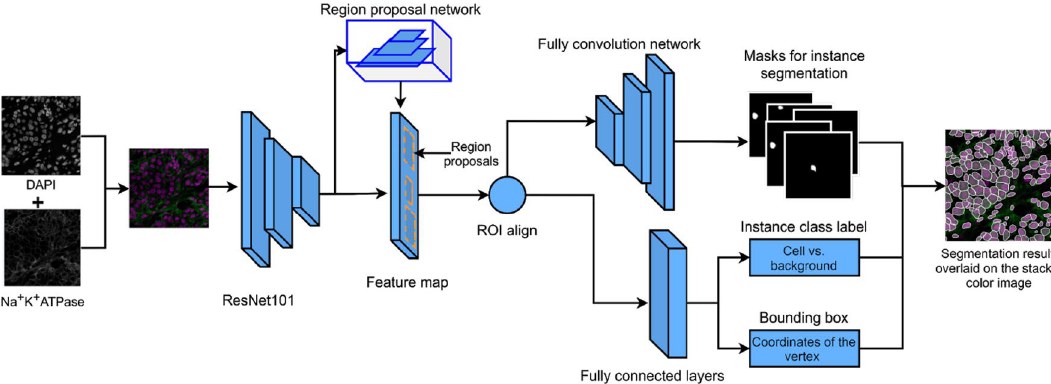
Figure 4. Mask R-CNN workflow for single cell segmentation of multiplexed images. The input images are the color stacked images from the DAPI and Na + K + ATPase -stained single channel images. The input went through the backbone (i.e. ResNet101) to form the feature map. Another branch went through the region proposal network to generate the instance candidate (i.e. region proposals) on the feature map. The following branches are: (1) full convolutional network for segmentation for the proposed instances, (2) fully connected layers for classification and bounding box regression for the instances. This figure is created using diagrams.net (https:// www. diagr ams.